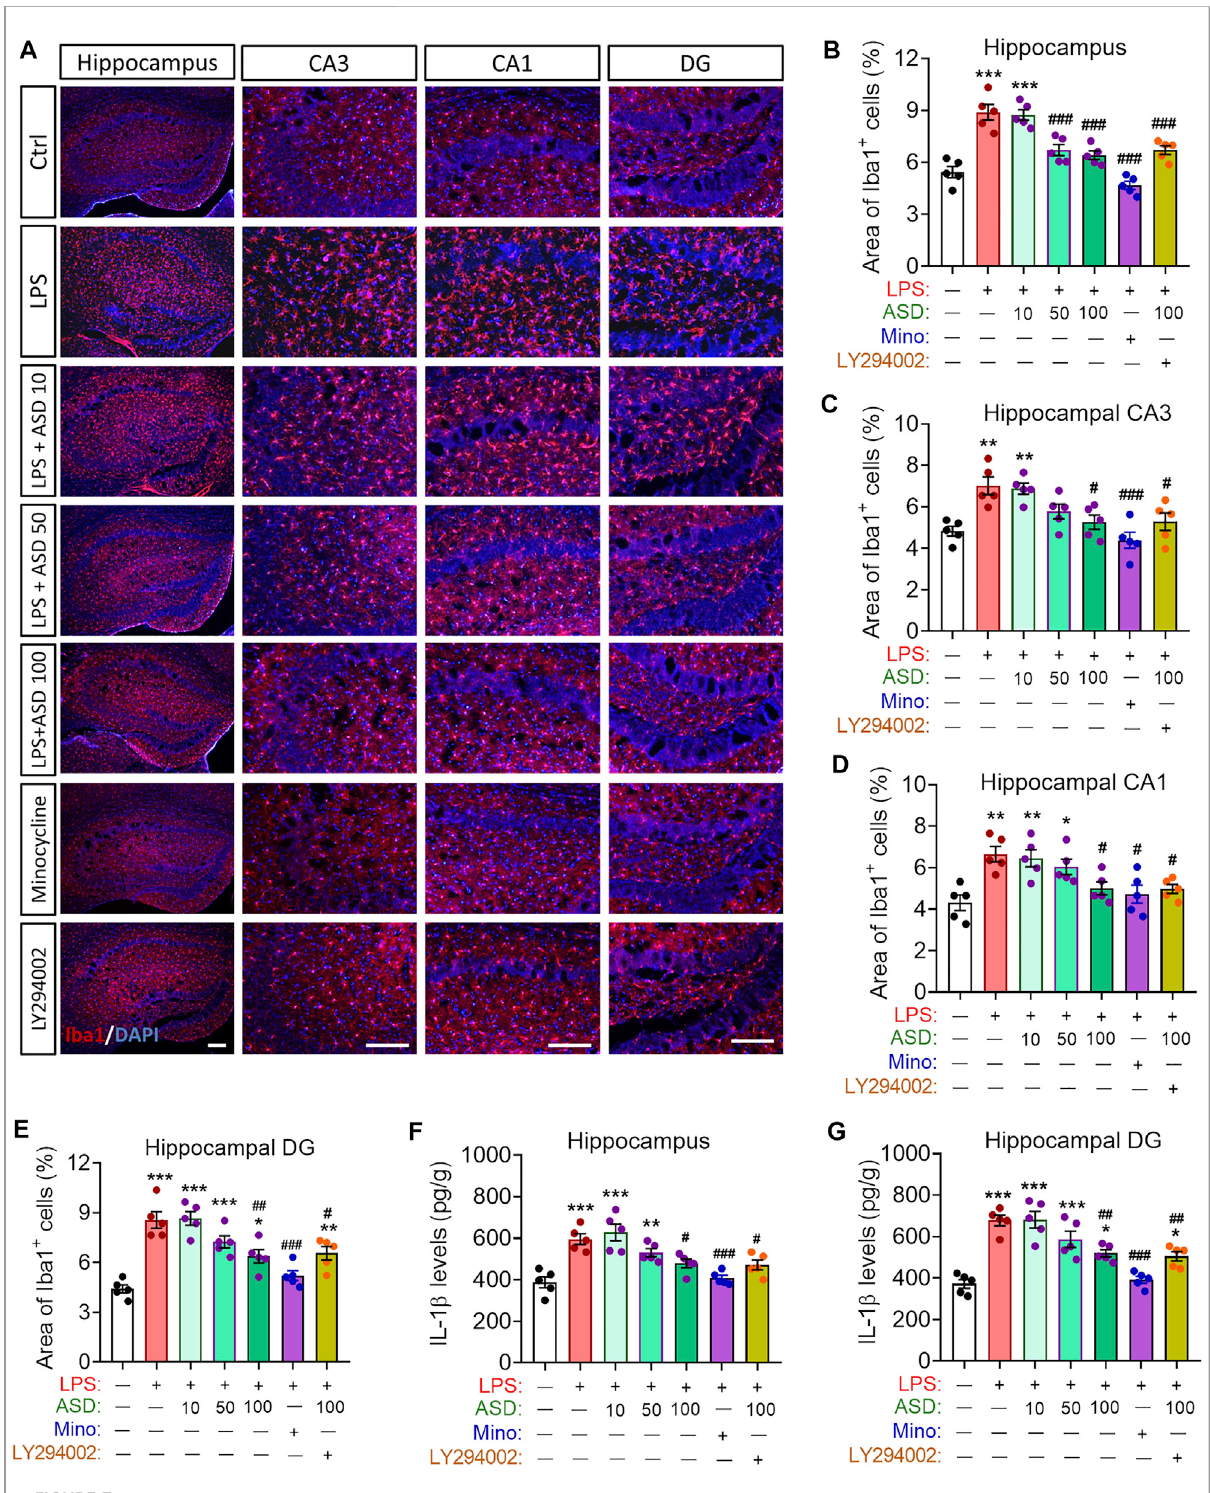
FIGURE 7 Effects of ASD on microglia, astrocyte numbers and IL-1 β levels in neurogenic niche of mice chronically exposed to LPS. (A) , Representative fl uorescence micrographs showing the morphology and density of microglia in the hippocampus of mice treated with saline (Ctrl) or lipopolysaccharide (LPS), followed by akebia saponin D (ASD) or minocycline. Microglia were labeled with antibody against ionized calcium binding adapter molecule 1 (Iba1) (red) and nuclei, with 4 ’ ,6-diamidino-2-phenylindole (DAPI) (blue). Scale bar, 100 μ m. (B – E) , Quanti fi cation of the percentagesoftotalareacontainingIba1+cellsinhippocampalCA3(C),CA1(D)anddentategyrus(DG)(E)forevaluatingchangesinthemorphology